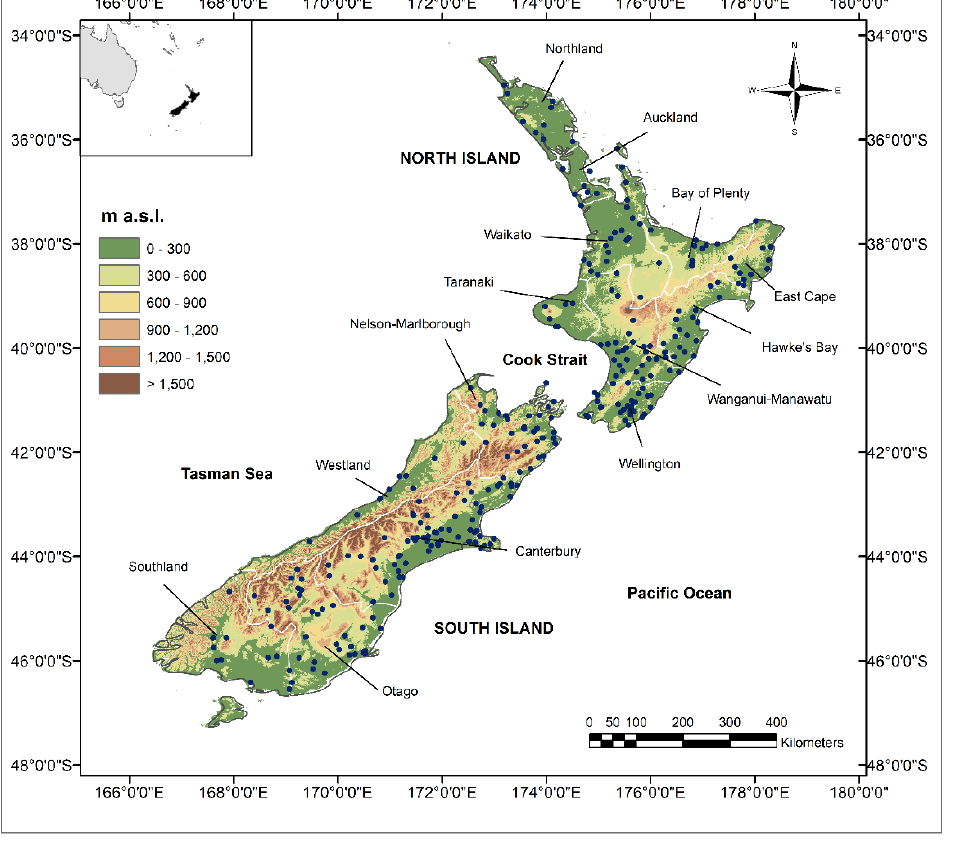
Figure 1. Geographic localisation of New Zealand and the selected 294 rain gauges (blue dots) over a digital elevation model (DEM).